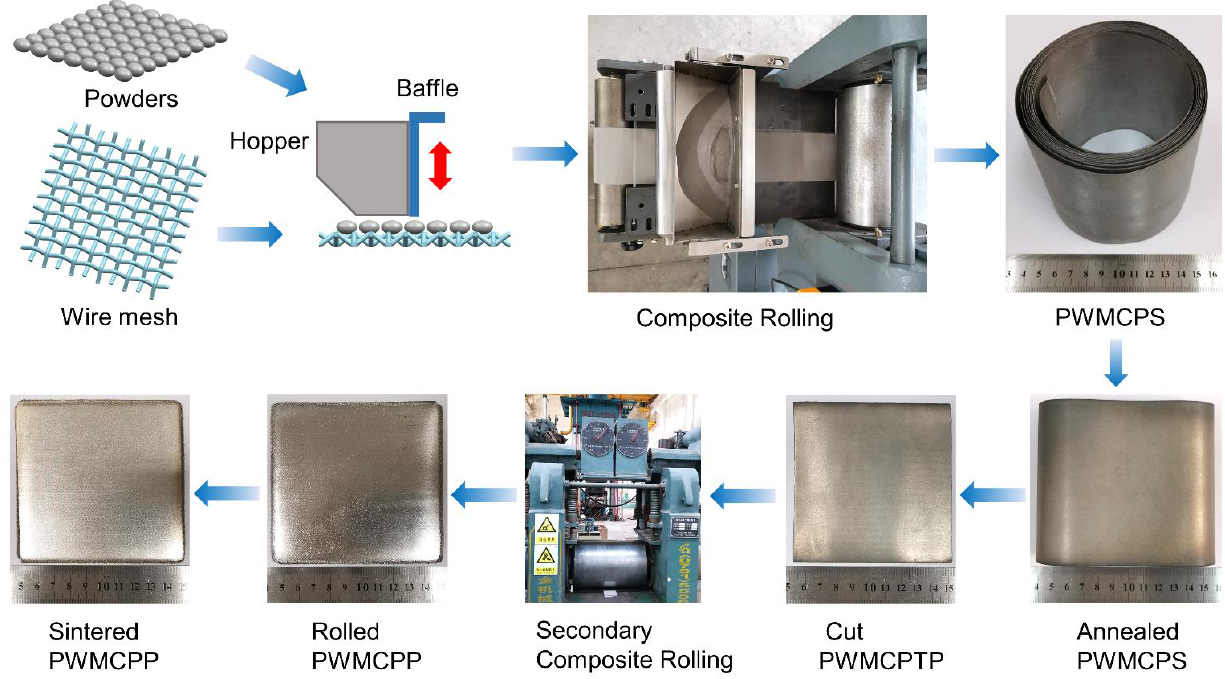
Figure 1. Manufacturing processes of the PWMCPPs. In order to reflect the differences clearly among three groups of specimens: with dif- ferent wire mesh volume fractions, with different wire mesh diameters, and with different sintering temperatures, the processing parameters of different PWMCPPs are summarized in Table